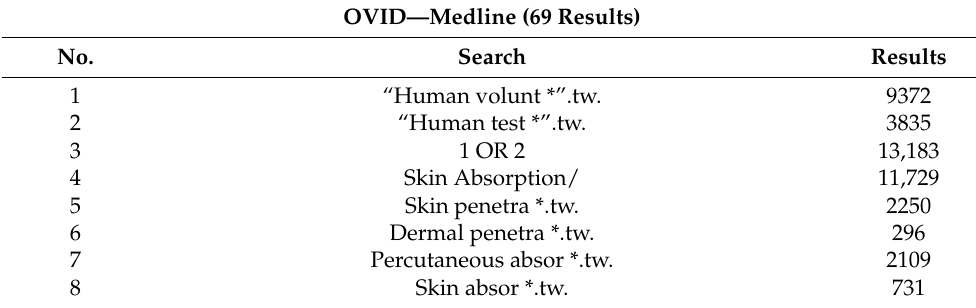
Table 1. Full systematic literature searches of the four databases. Wildcard searches are marked with an asterisk